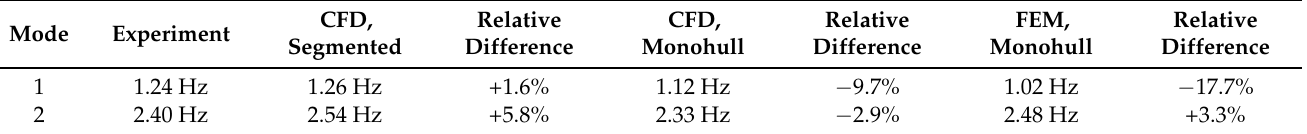
Table 3. Wet natural frequencies for the first two vibration modes, in Hz, obtained with different methods and